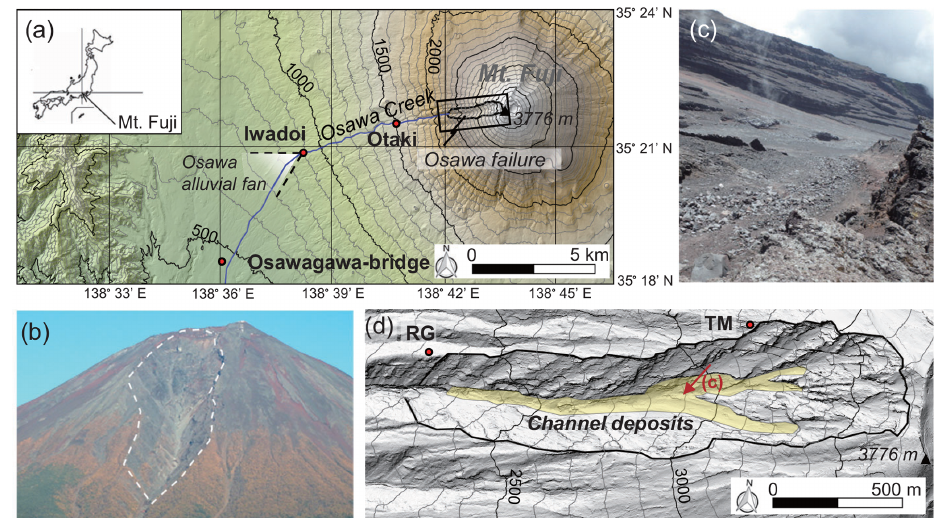
Figure 1. Topographic map and photographs of the Osawa failure. (a) Topographic map of the area around the Osawa failure and Osawa Creek. The area shown in (d) is located within the black-outlined box. (b) Full view of Mt. Fuji. The location of the Osawa failure is indicated by the white dashed line. (c) Channel deposits in the Osawa failure. The location where this photograph was taken is indicated by the red arrow in (d) . (d) Topographic map of the area around the Osawa failure. RG and TM indicate the locations of a rain gauge and ground temperature sensors, respectively. The summit meteorological station is located at the triangle on the mountain peak.